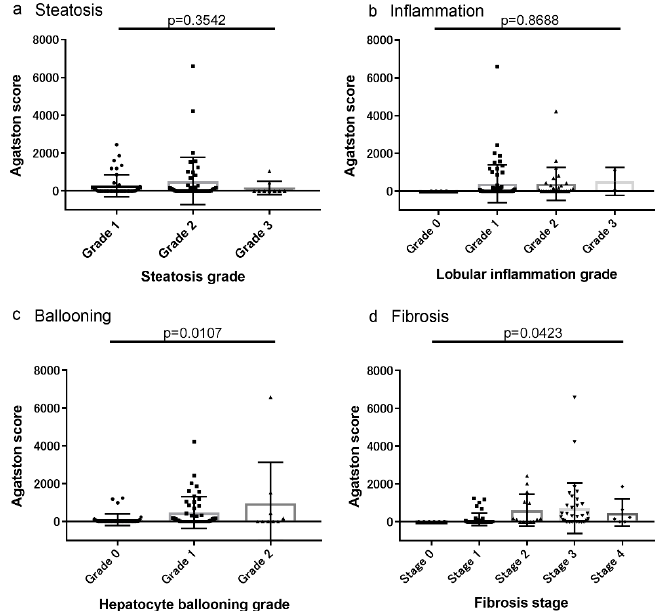
Figure 3. Association between the coronary artery calcium score (CACS) and the histologic characteristics ( a ) Steatosis, ( b ) inflammation, ( c ) Ballooning, and ( d ) Fibrosis. CACS was positively correlated with the hepatocyte ballooning grade and the stage of liver fibrosis.